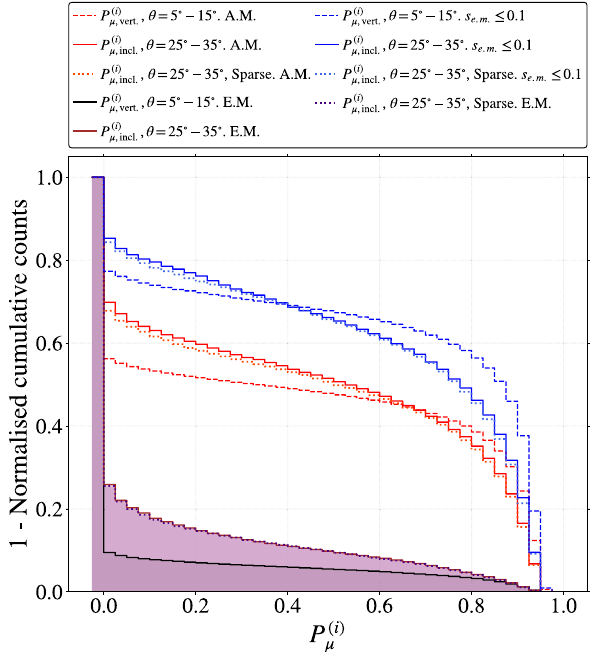
Fig. 9 Normalised inverse cumulative function of the probability P ( i ) μ ofstationsfromproton-inducedeventswith θ 0 ∈ [5 ◦ ; 15 ◦ ](densearray) and θ 0 ∈ [25 ◦ ; 35 ◦ ] (dense and sparse